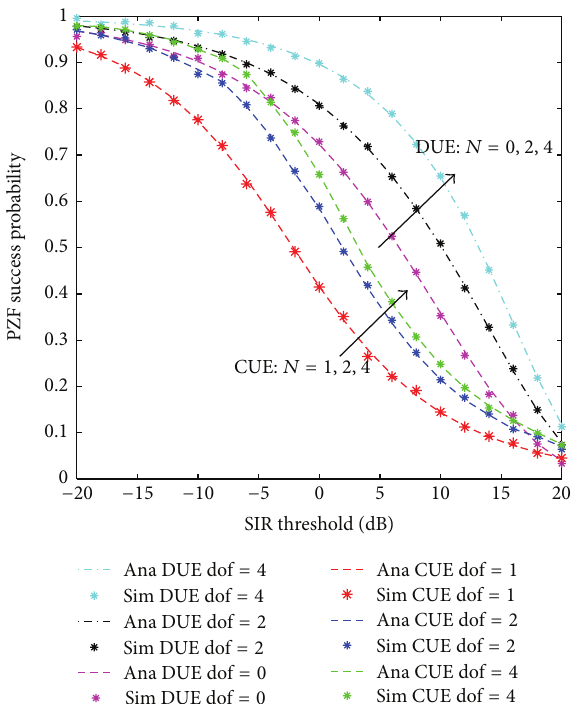
Figure 4: Cellular and D2D communication success probability for difference 𝑁 in PZF strategy. DUE dof = 0 1 2 4 denotes 0, 1, 2, 4 dofs are allocated to DUE for interference cancellation, respectively. CUE dof = 0 1 2 4 denotes 0, 1, 2, 4 dofs are allocated to CUE for increasing the diversity gain, respectively.